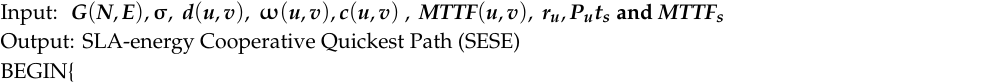
Algorithm 1: Secure, Energy- and SLA-E ffi cient (SESE) Algorithm without involvement of malicious